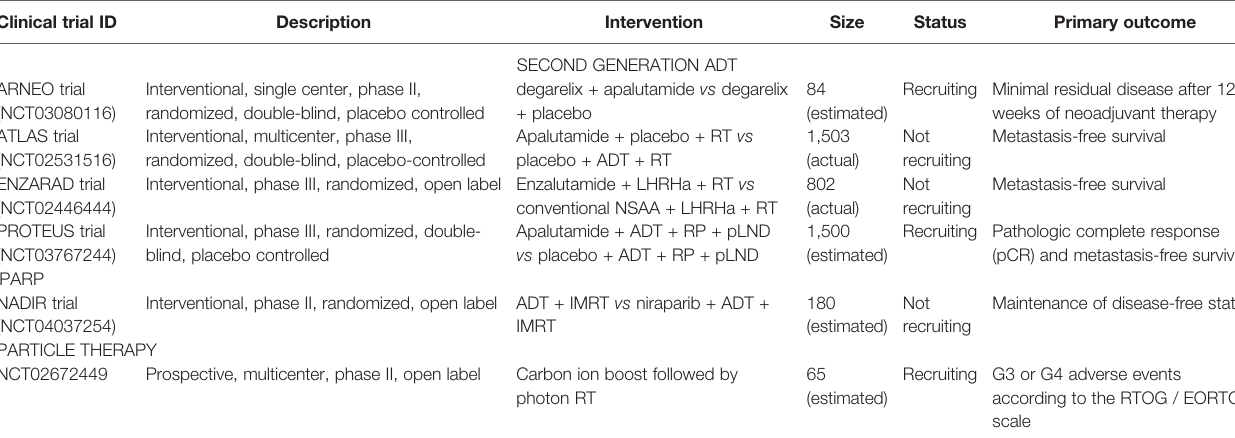
TABLE 1 | Ongoing